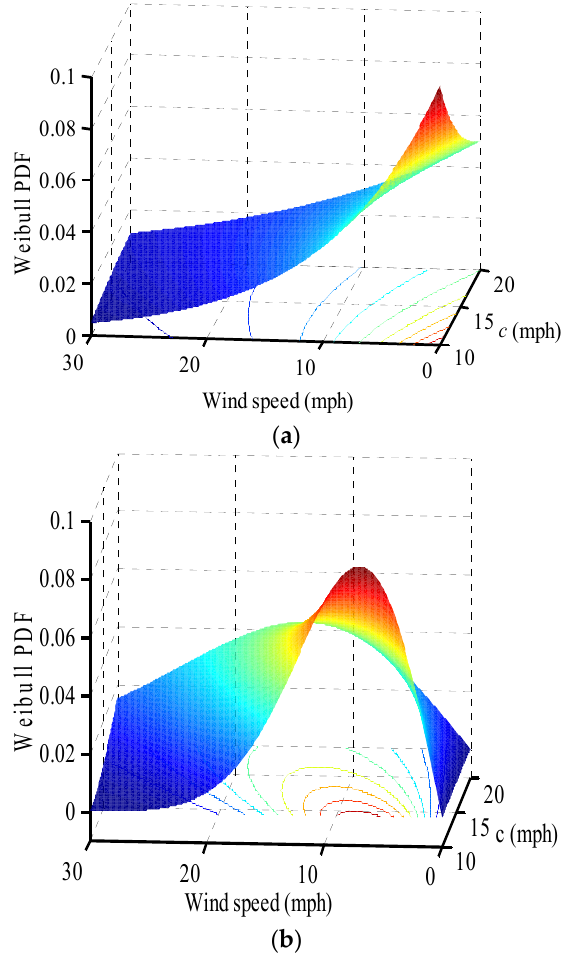
Figure 7. Three-dimensional Weibull PDF vs. wind speed and scale factor (1 mph = 0.446 m/s). ( a ) k = 1; ( b ) k =